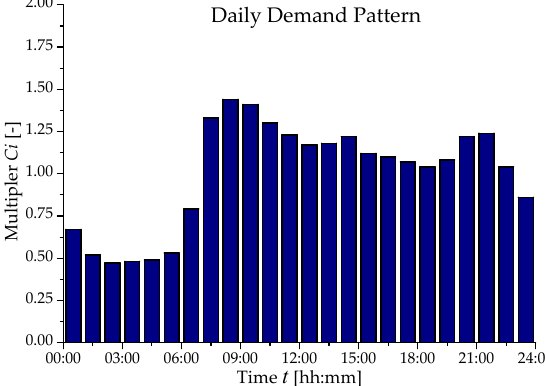
Figure 1. Daily demand pattern for two considered